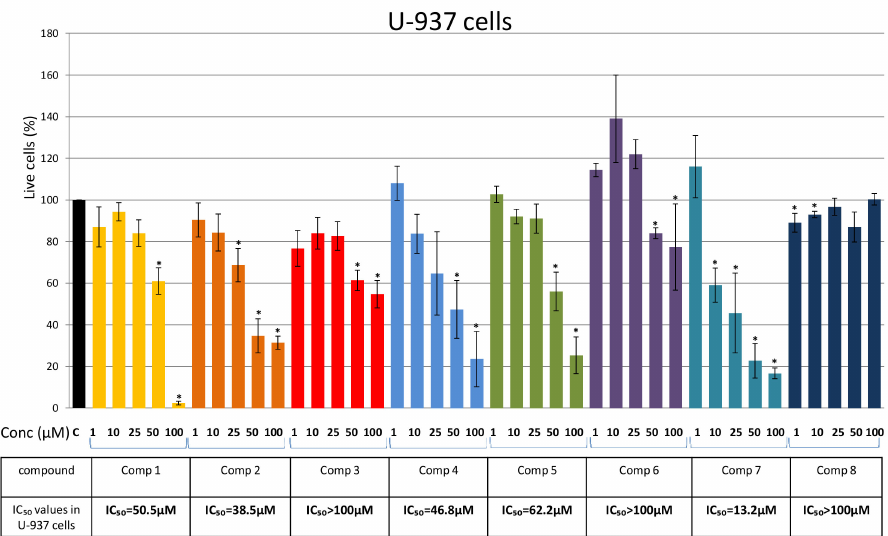
Figure 4. Effects of Compounds 1–8 on U-937 cells. Cells were treated for 48 h with increasing concentrations (1 µ M, 10 µ M, 25 µ M, 50 µ M, and 100 µ M) of the tested compounds and cell viability was assessed using an MTS assay and expressed as the percentage of absorbance relative to the vehicle control (U-937 cells treated with DMSO), which was set at 100%. Data are presented as the mean ± SEM of at least three independent experiments. An asterisk denotes a significant difference from the control (* p < 0.05). SEM—standard error of the